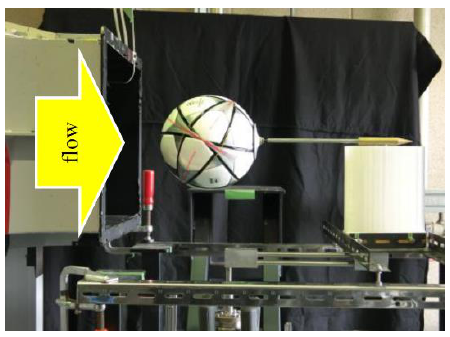
Figure 4. Fluid force measurement (side).